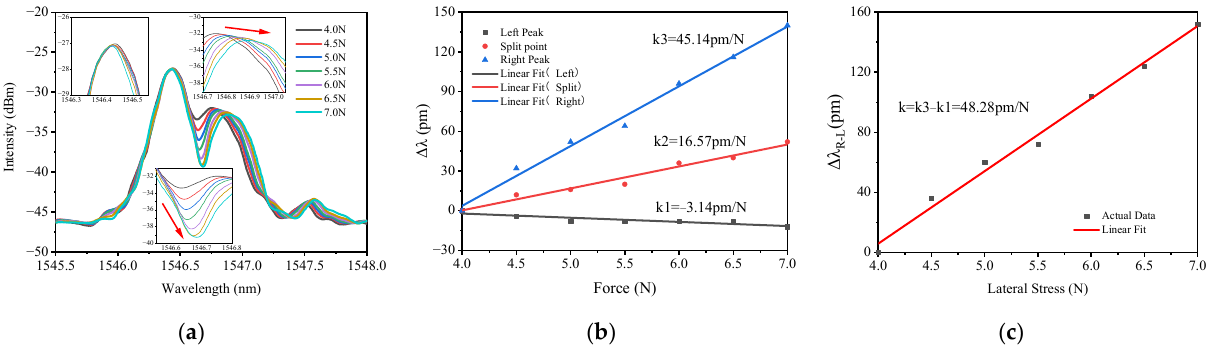
Figure 9. Force dependence of the spectral characteristics of the FBG under pressure loading. ( a ) Reflection spectra at different load pressures. ( b ) Response curve of wavelength variation of ∆ λ L , ∆ λ ∆ λ S and R of the FBG relative to force variation. ( c )